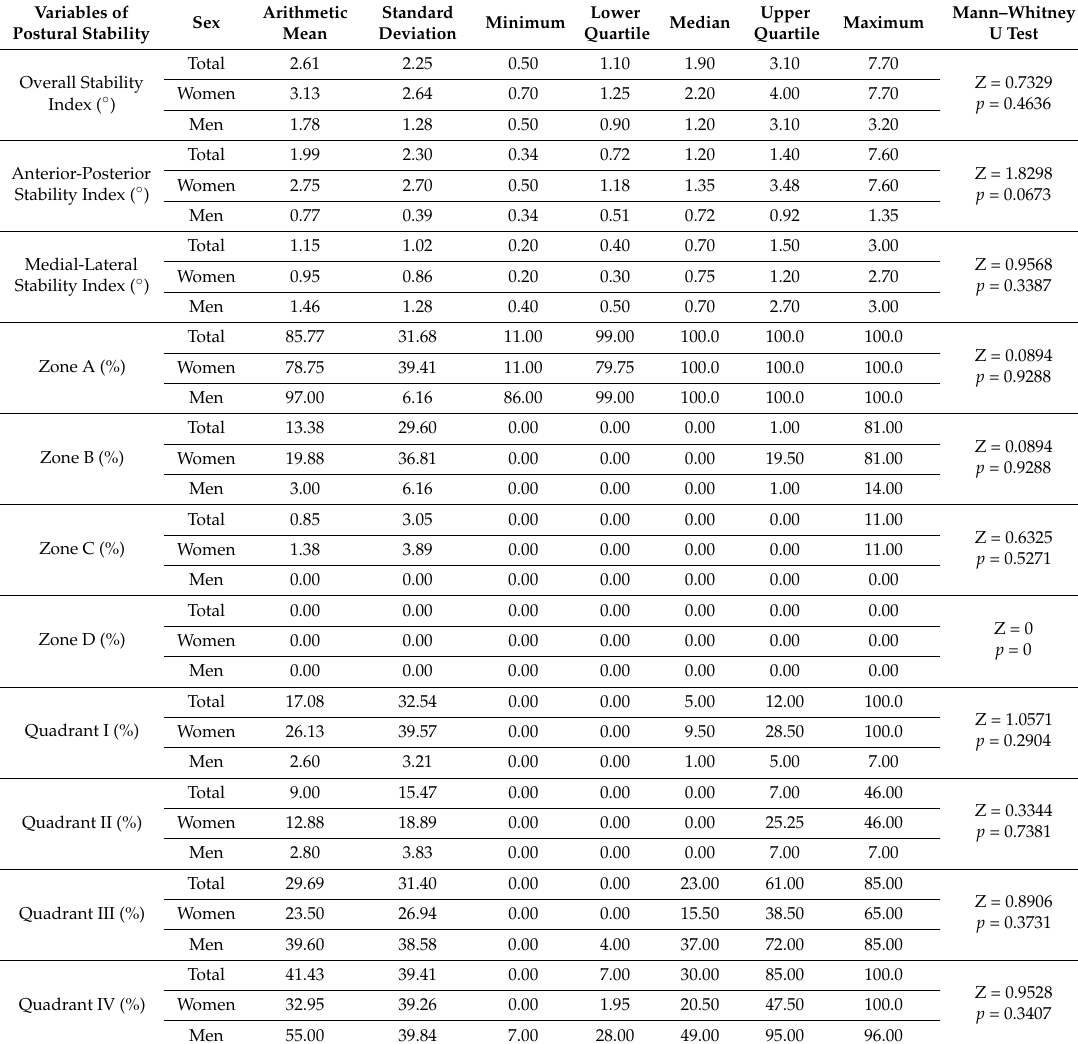
Table 2. Sex and postural stability before L-dopa